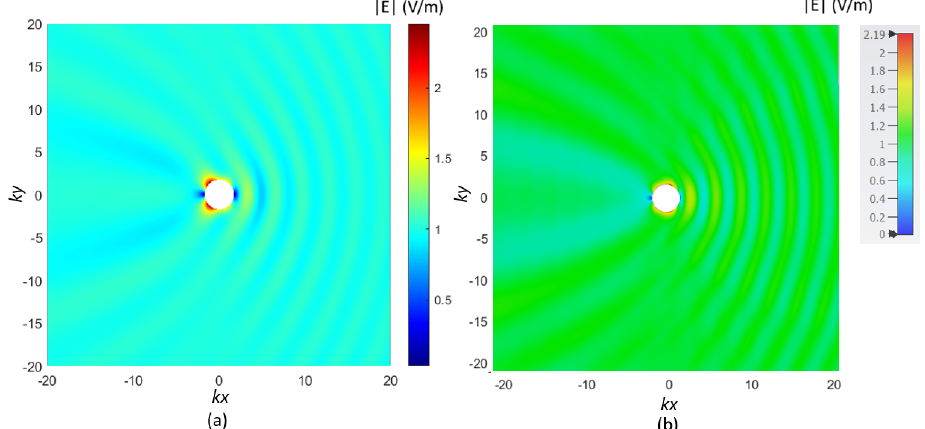
Figure 11. Magnitude of the E-field across the xy -plane: ( a ) spheroidal geometry with the same geometrical parameters considered in Figure 10 (analytical approach); ( b ) spherical geometry (2-D) (CST Microwave Studio). Sphere radius was kr = 1.7321. TE